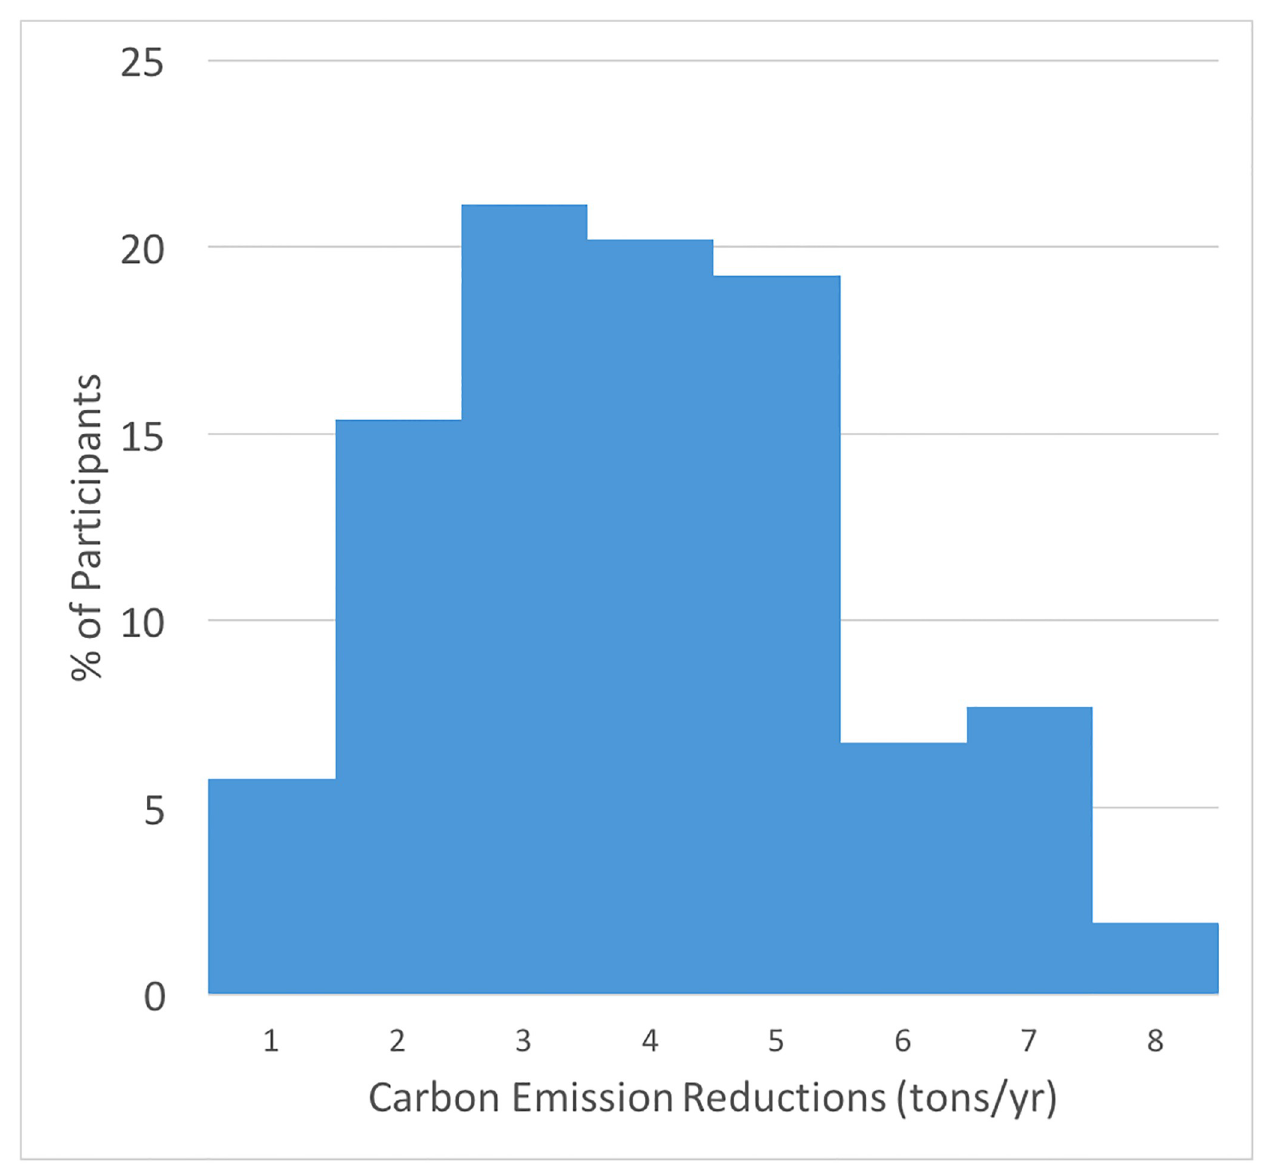
Fig 3. The distribution of carbon emission reductions (tons/year) for participants (n = 104) as a result of the COMM 168